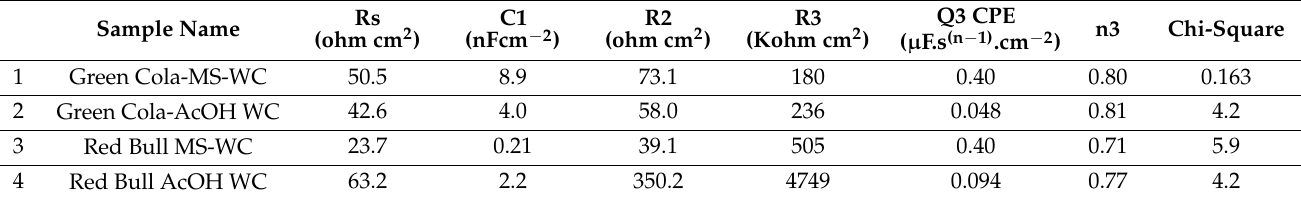
Table 1. R1—solution resistance, C1—coating capacitance, R2—coating charge transfer resistance, R3— aluminium charge transfer resistance, Q3 CPE—double layer capacitance (constant phase element), n3—exponent; these are the parameters of electrochemical impedance for coated Green Cola and Red Bull samples.